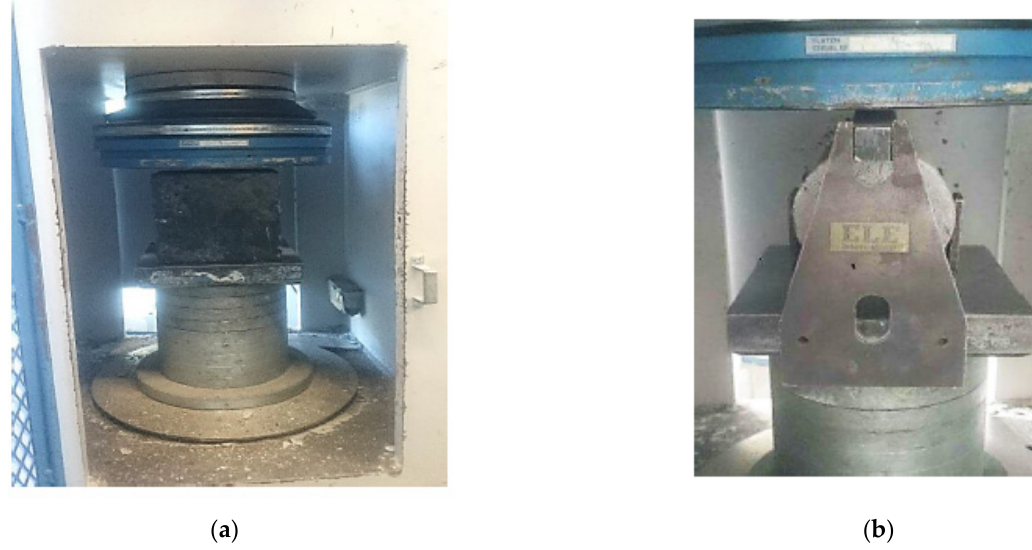
Figure 1. Concrete Testing ( a ) Compressive Strength Test ( b ) Split Tensile Strength Test.